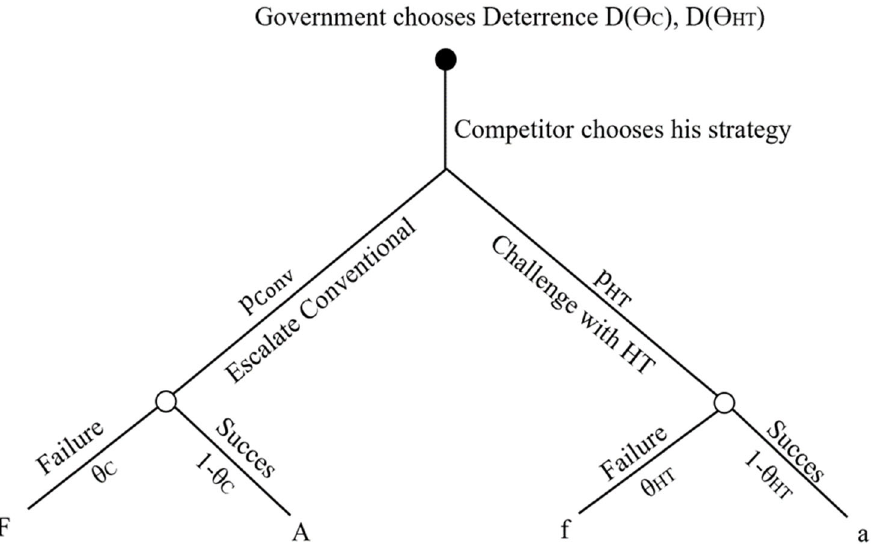
Figure 3. Interactions between a defender and a challenger (Extensive form representation). Source: simplified representation of the model presented in Balcaen et al. (2021).